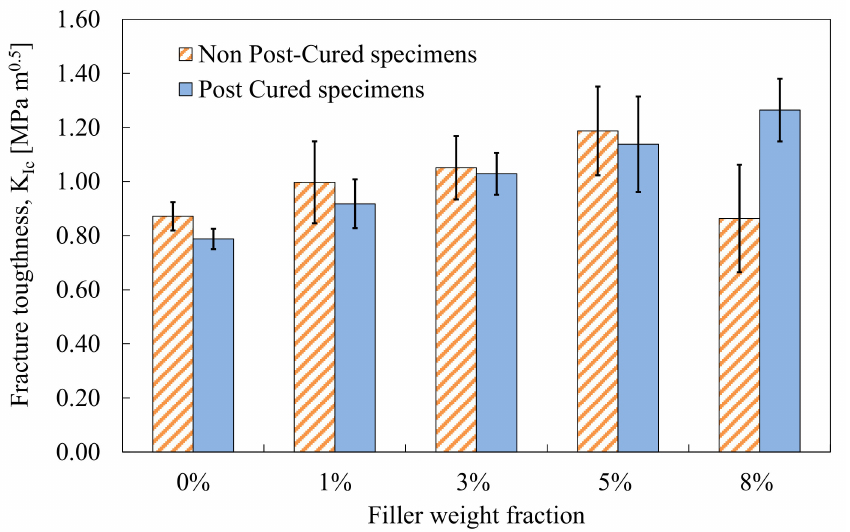
Figure 3. Mode I fracture toughness of neat and nanomodified specimens. DGEBA-based epoxy modified with silica nanoparticles. Post-curing was carried out in an oven at 60 ◦ C for 15 h